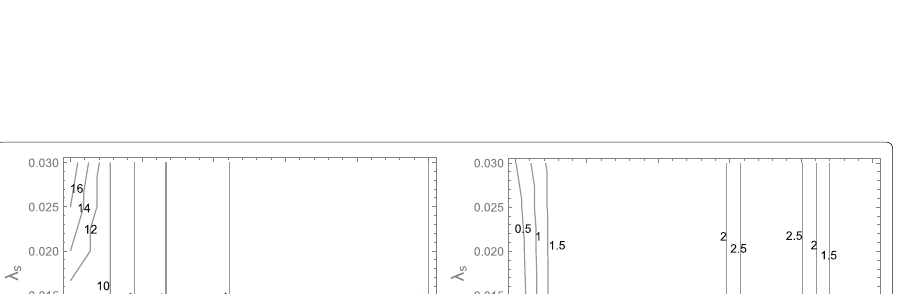
Fig. 6 Upper left: “ Q / T ↑ as β r ↑ ” and Q ( 0.1 )/ T ( 0.1 ) | β “ Q / T ↑ as β n ↑ ” holds. Lower left: “ W ↑ as β r ↑ ” holds. Lower right: β n has a large impact on W . “ W ↑ as β n ↑ ” holds. For all figures, solid lines correspond to the previous model ( β r = 1, β n = 0), λ s = 0.01, λ n = 0.0015, and N i = 10 4